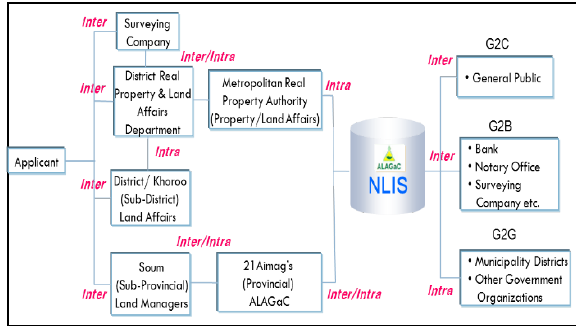
Figure 4. Proposed model of cadastral system in institutional connection with NLIS